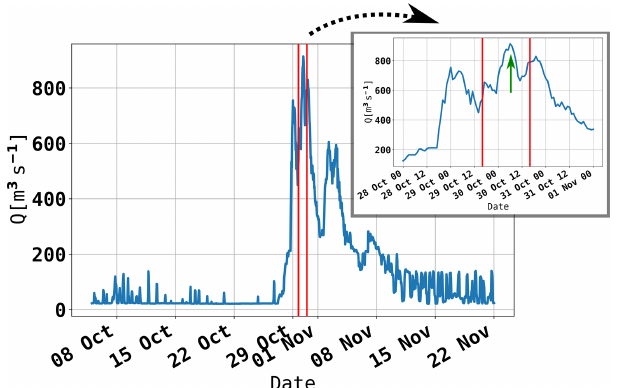
Figure 2. So ˇ ca runoff during October and November 2018, as mea- sured at an upstream river gauge (operated by ARSO) at Solkan, Slovenia. Vertical red lines indicate the time window of the drift. The green arrow in the inset marks the approximate time of the windsurfer’s entering the river